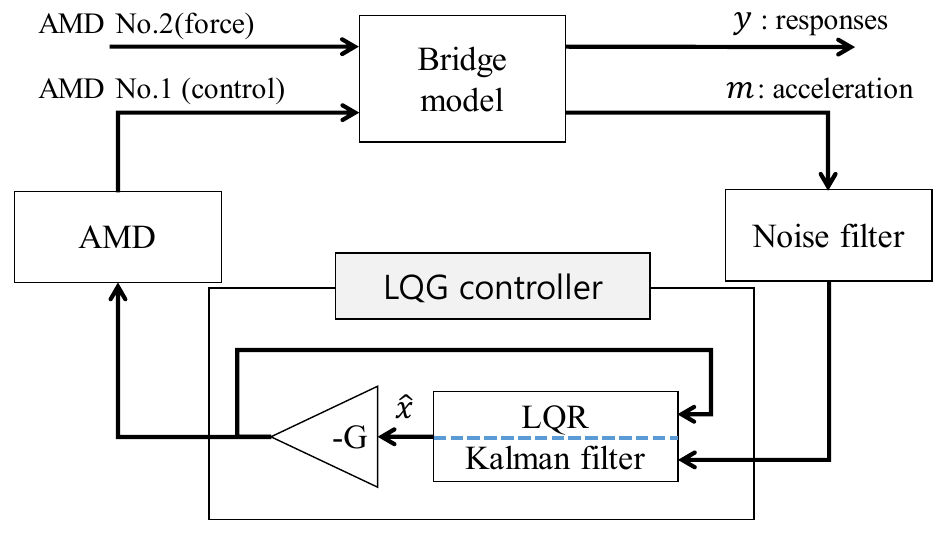
Figure 7. Block diagram of the whole system.